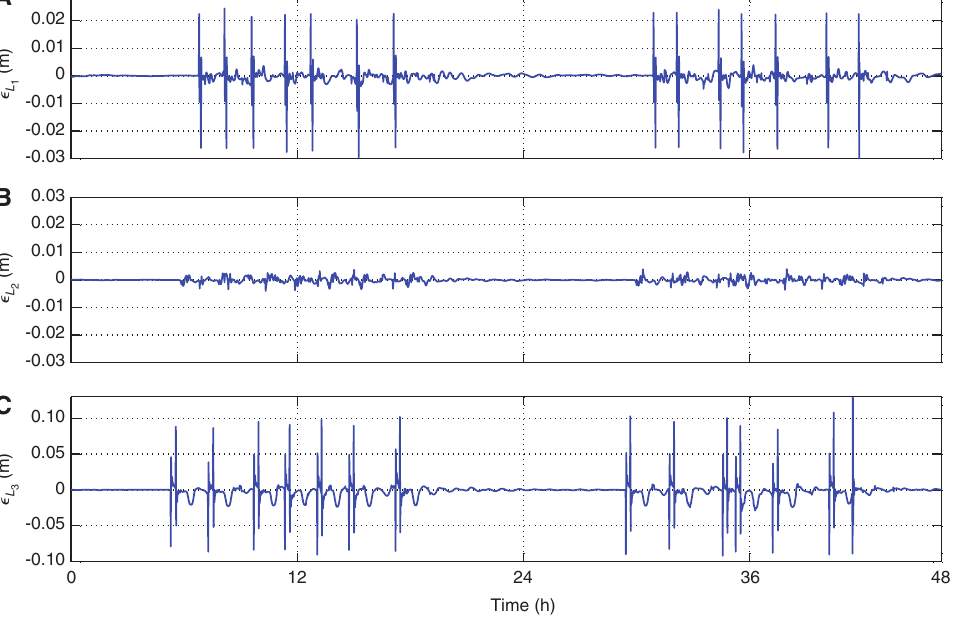
( ) k (cid:31) – Cuinchy, (B) L 1